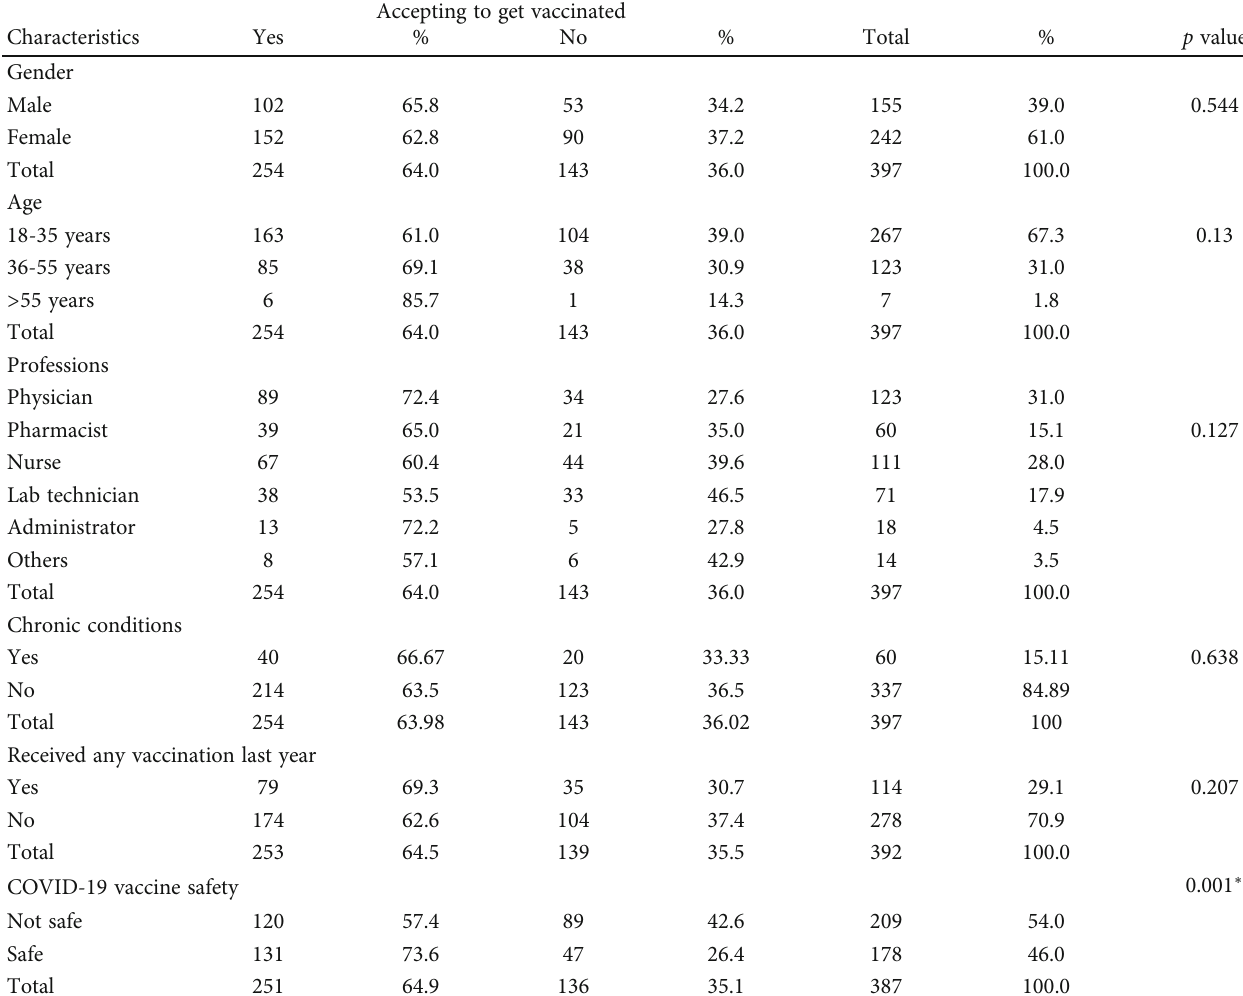
Table 5: Association between acceptability of COVID-19 vaccination and the characteristics of the participants. Accepting to get